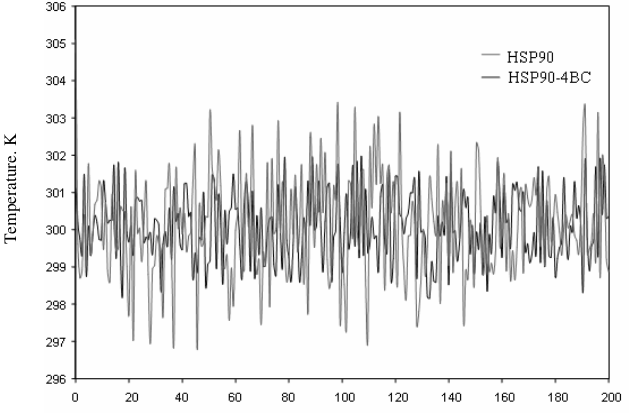
Figure.4. Root-mean-square atom positional deviation (RMSD) in nm from the x-ray (crystal) structure as function of time in ps for the simulation of 4BC using the GROMOS96 force field.